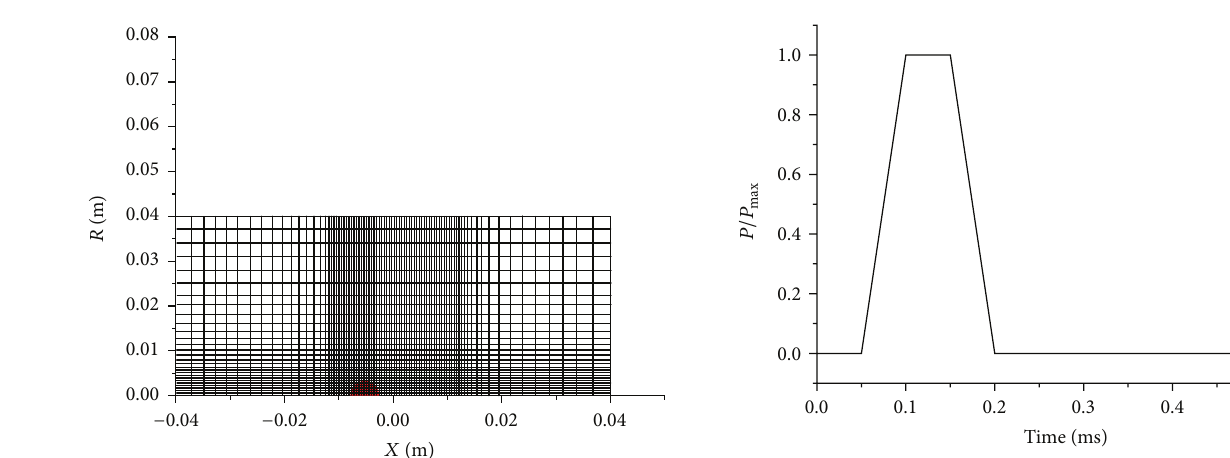
Figure 2: Configuration and grids of the calculation domain.